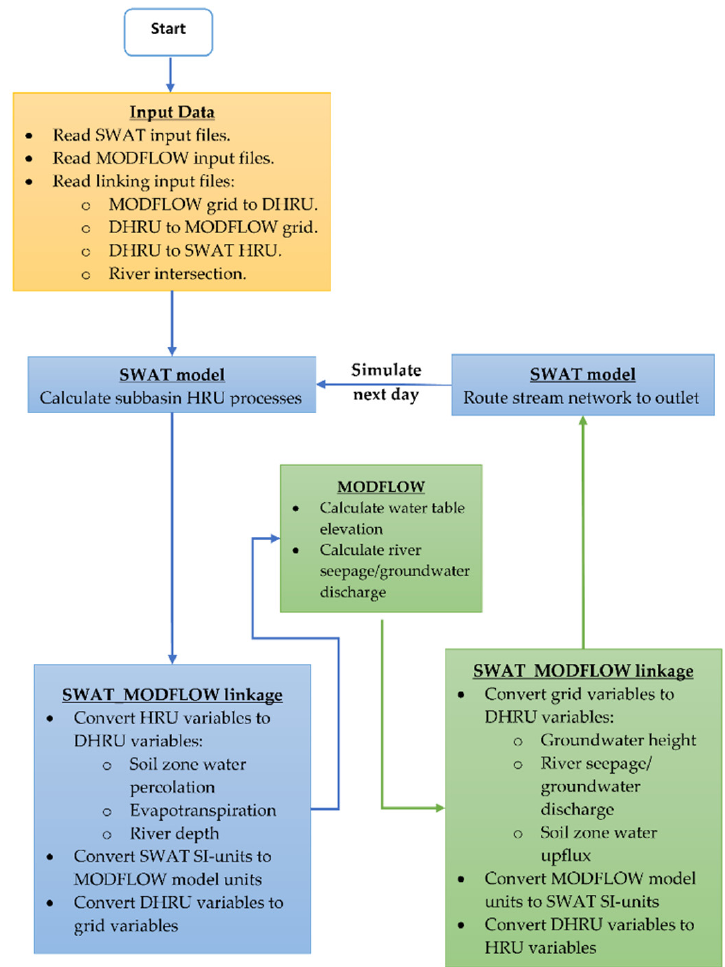
Figure 6. Flowchart presenting the model code sequence of the coupled SWAT-MODFLOW model [9].